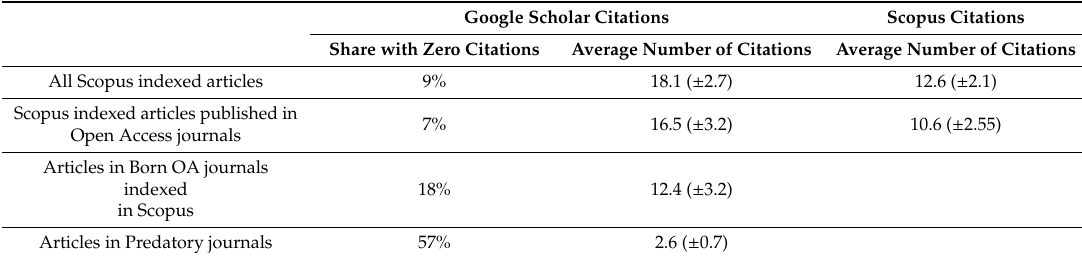
Table 2. Descriptive statistics for the citations to articles published in 2014 in predatory OA journals as well as to three control groups. The 95% confidence intervals are indicated in parentheses after the